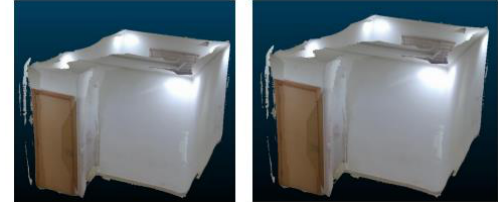
Figure 14. Room case: raw point cloud on the left and point cloud from filtered depth images on the right.